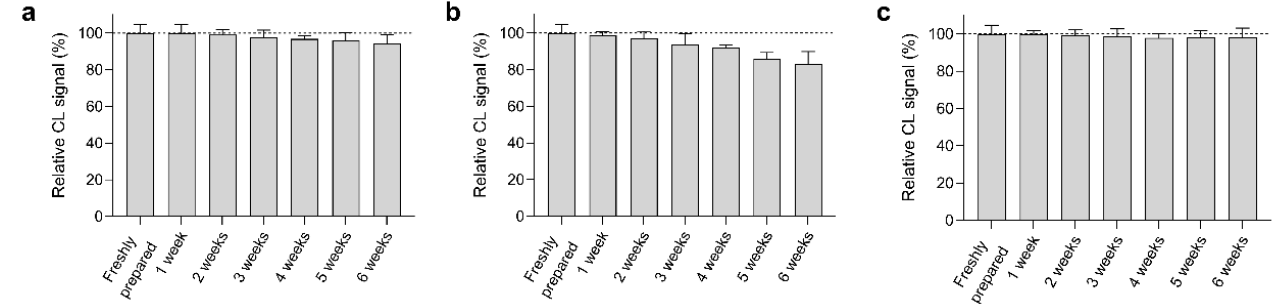
Figure 11. Decrease in the CL signal measured upon storage at 4 °C for origami µPADs containing the reagents ( a ) OVA-MBs, ( b ) anti-OVA-HRP, and ( c ) luminol/enhancer and sodium perborate. The remaining reagents were loaded in the µPADs just before the measurement. Each of the data are the mean ± SD of three measurements.